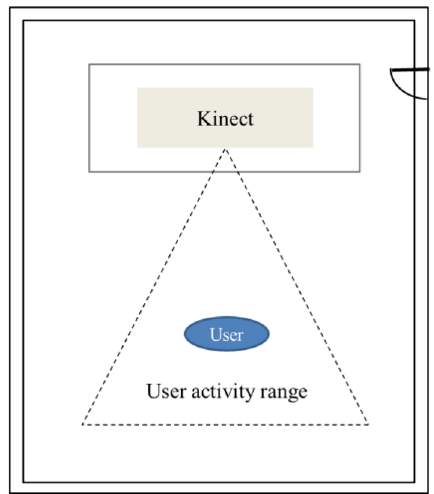
Figure 4. Top view of the room for image